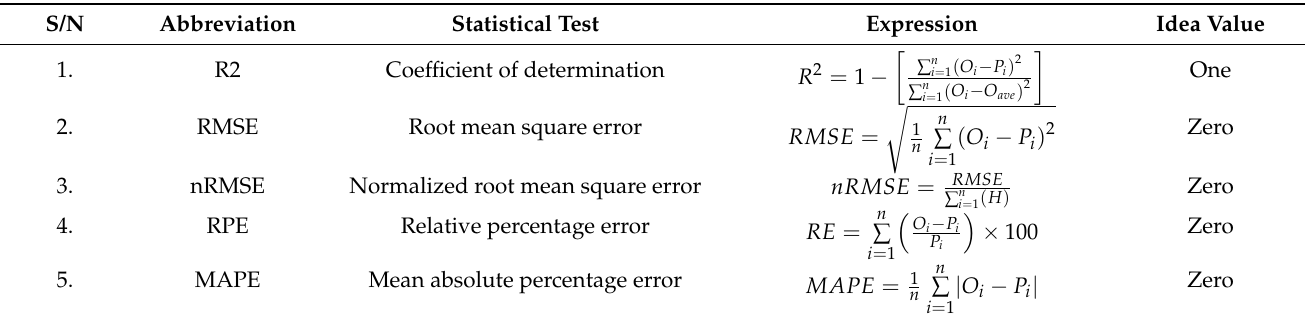
Table 7. Details of the statistical